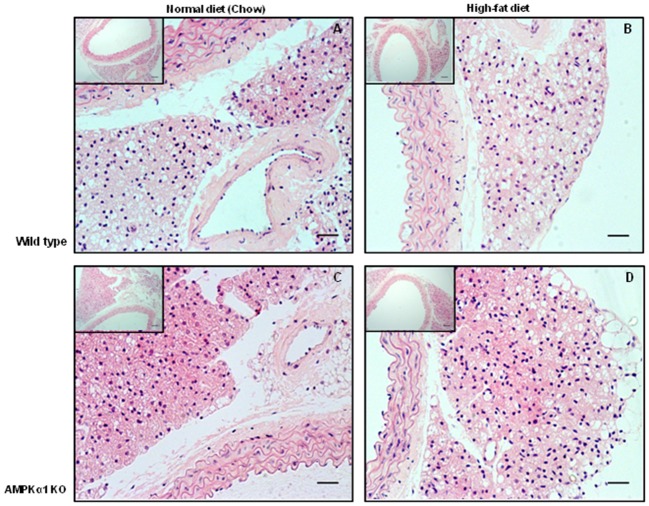
Effect of 12 weeks high-fat diet on thoracic aorta PVAT. Aortic rings from wild type mice (A,B) and AMPKα1 knockout mice (C,D) were harvested from mice fed normal diet (chow) or high fat diet and stained with H&E. Nuclei appear blue/purple whereas cytoplasm is stained pink. Scale bar = 20 μm. Representative images of n = 5 separate animals per group.